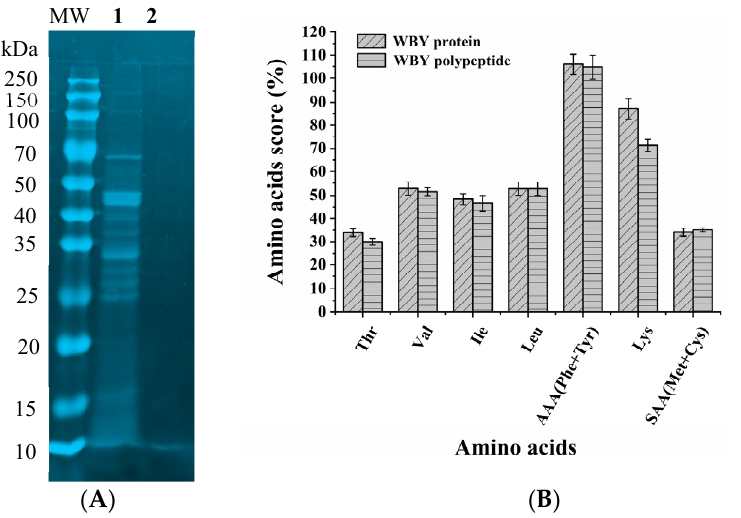
Figure 5. Coomassie-stained SDS-PAGE electrophoretic profile ( A ) of WBY protein ( 1 ) and polypeptide ( 2 ) and amino acids score of WBY protein and polypeptide ( B ). M5 Prestained Plus Protein Ladder (10–250 kDa) with 40 kDa as the protein weight standard.